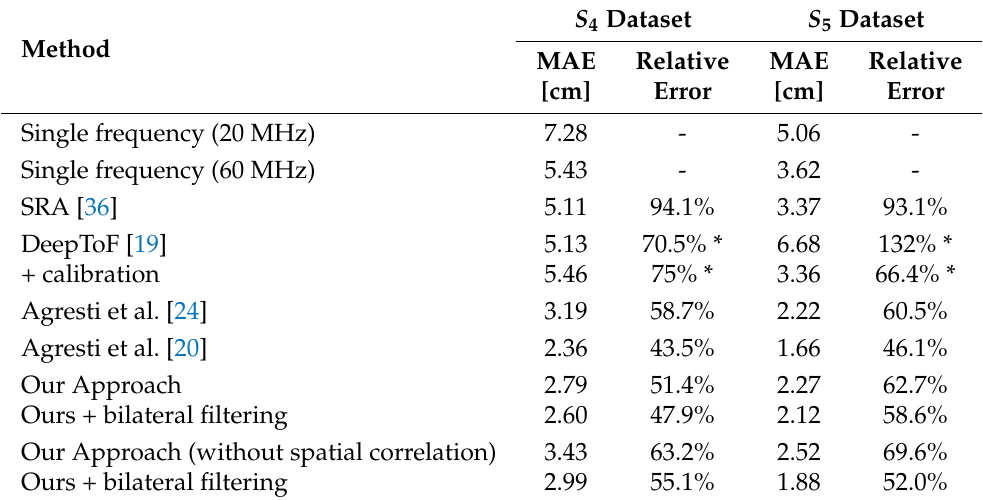
Table 3. Quantitative comparison between several state-of-the-art Multi-Path Interference (MPI) correction algorithms on the real datasets S 4 and S 5 . Each row reports the depth MAE and the relative error obtained applying the corresponding method w.r.t. the maximum employed frequency (60 MHz for all methods except 20 MHz for [19]